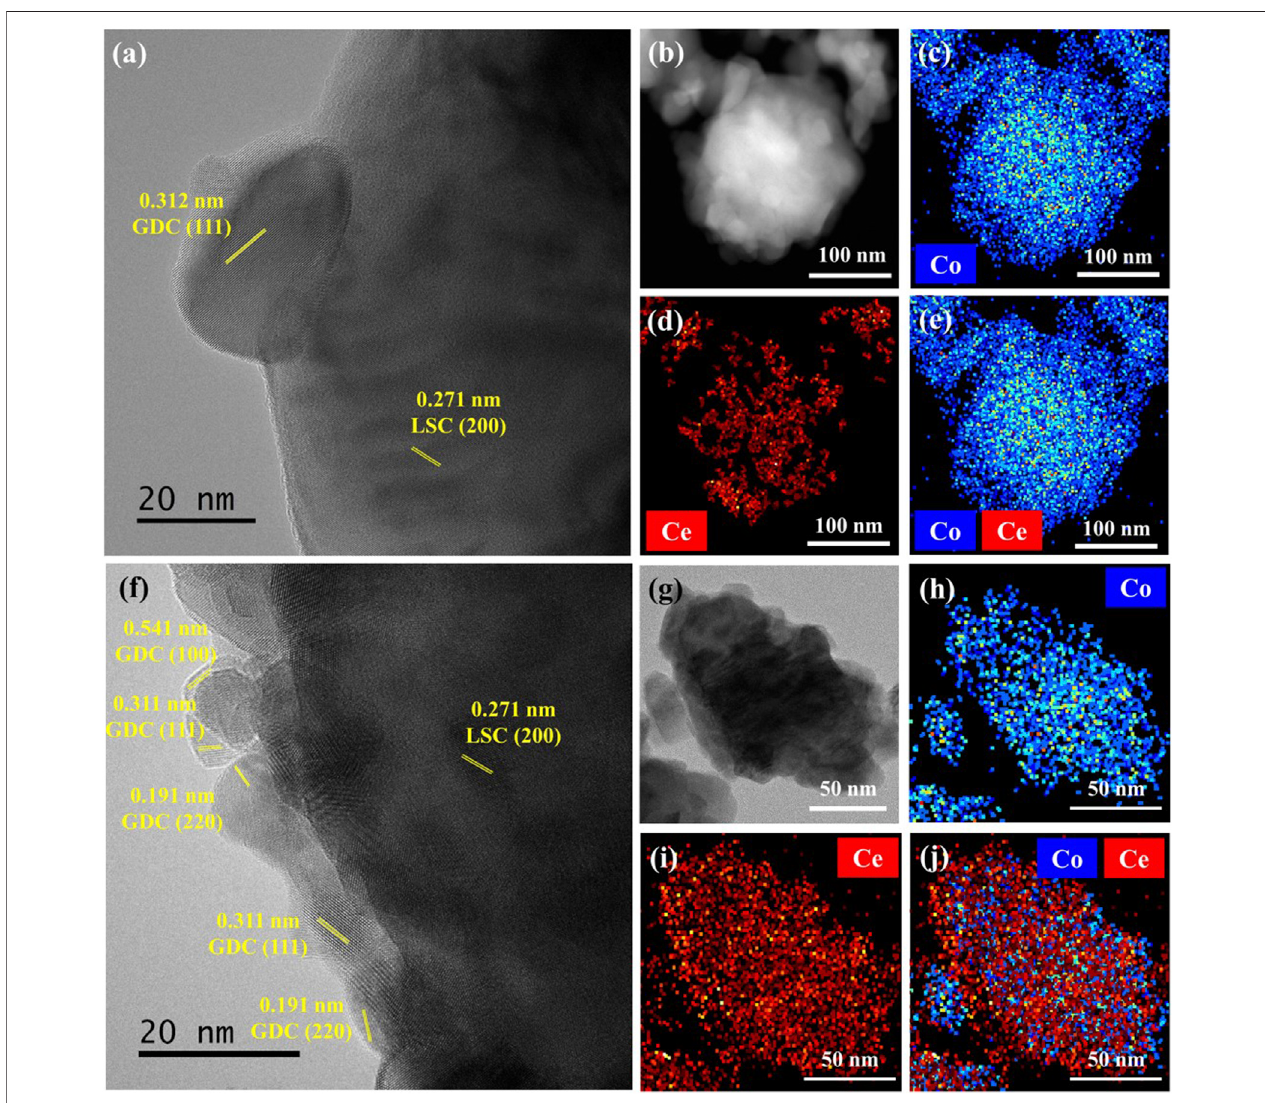
FIGURE 4 | HR-TEM images of LSC-GDC powders prepared using (A) conventional ESD and (F) SGC-assisted ESD. TEM-Energy dispersive X-ray dispersive analysis (EDAX) elemental mapping of Co. and Ce for LSC-GDC powders using (B – E) conventional ESD and (G – J) SGC-assisted ESD.